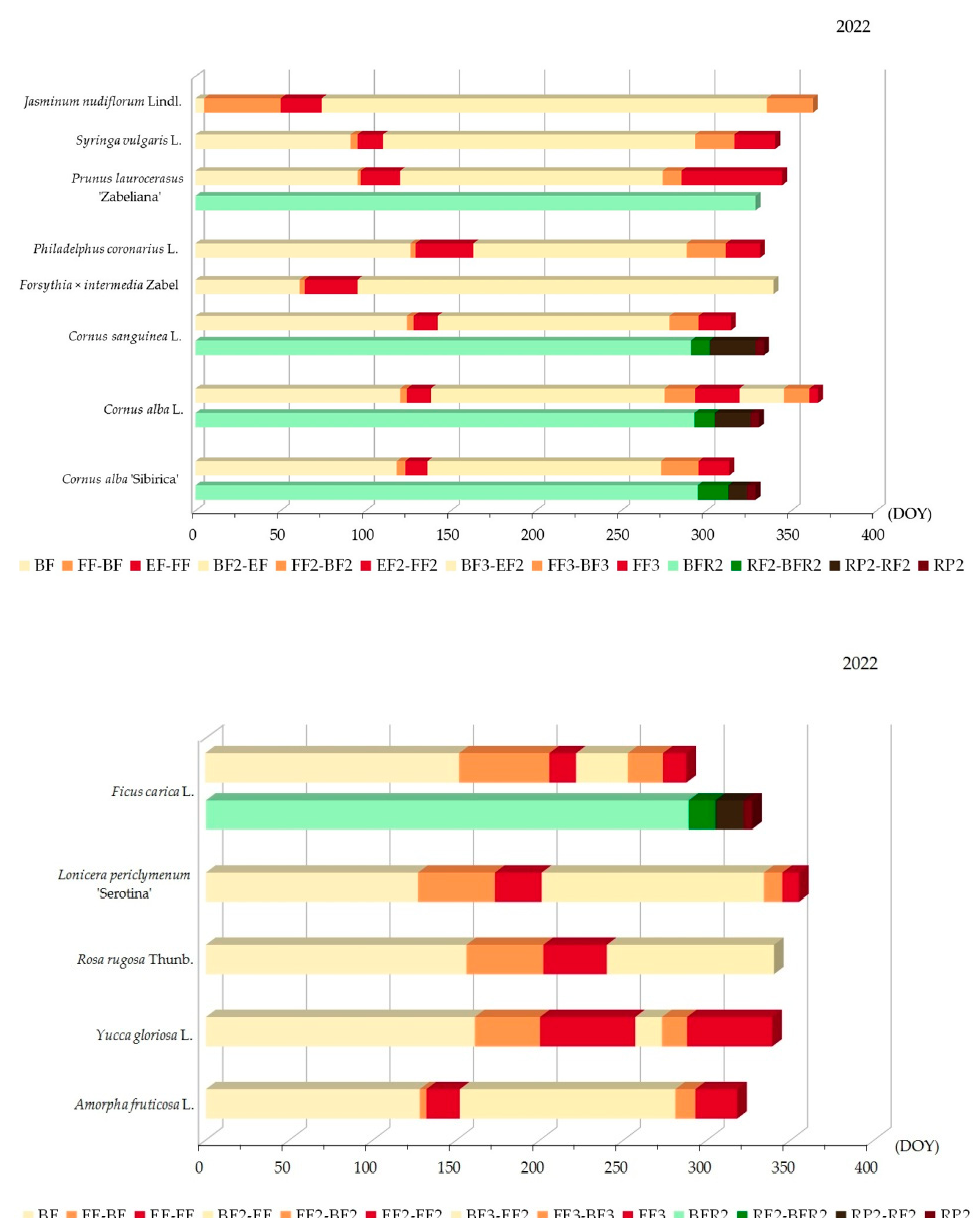
Figure 8. Phenological observations: periods and DOY for the beginning of first flowering (BF), full first flowering (FF), the end of first flowering (EF), the beginning of second flowering (BF2), full second flowering (FF2), the end of second flowering (EF2), the beginning of third flowering (BF3), full third flowering (FF3), BFR2 (beginning of second fruit formation), RF2 (second appearance of first ripe fruits), and RP2 (second fruit ripening) for 13 woody taxa in 2022. From the beginning to the end of the first flowering (duration of flowering), a different number of days passed depending on the taxon (Figure 8): Jasminum nudiflorum Lindl. (69), Forsythia × intermedia Zabel (34), Syringa vulgaris L. (19), Prunus laurocerasus ‘Zabeliana’ (25), Cornus alba ‘Sibirica’ (18), Cornus alba L. (18), Lonicera periclymenum ‘Serotina’ (74), Amorpha fruticosa L. (24), Cornus sanguinea L. (18), Philadelphus coronarius L. (37), Ficus carica L. (70), Rosa rugosa Thunb. (84), and Yucca gloriosa L. (96). In 2022, Weeping Winter Jasmine, Border Forsythia, Common Lilac, Zabel’s Laurel, European Mock-Orange, Edible Fig, Rugosa Rose, and Spanish Dagger had an earlier